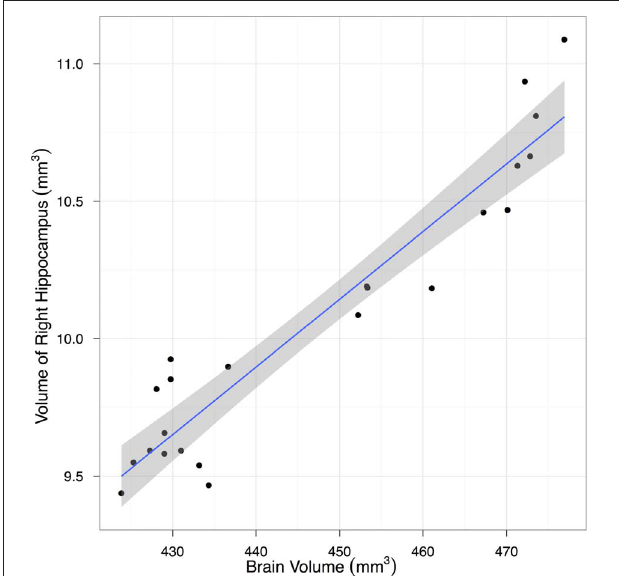
Table 2 | Standard deviations (expressed as percent of hippocampal volume) across three datasets.